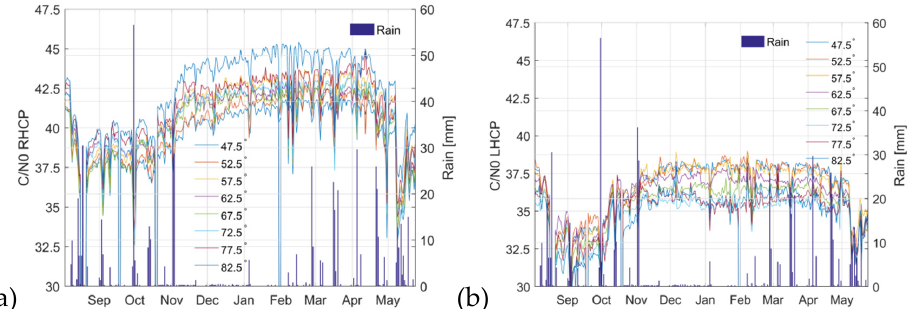
Figure 8. E ff ect of rain to the azimuthally averaged C / N 0 curves: ( a ) RHCP; and ( b ) LHCP. The curves Figure 8. Effect of rain to the azimuthally averaged C/N 0 curves: (a) RHCP, and (b) LHCP. The curves are plotted corresponding to the elevation angles from 47.5 ◦ to 82.5 ◦ angles in the legend. are plotted corresponding to the elevation angles from 47.5° to 82.5° angles in the legend.